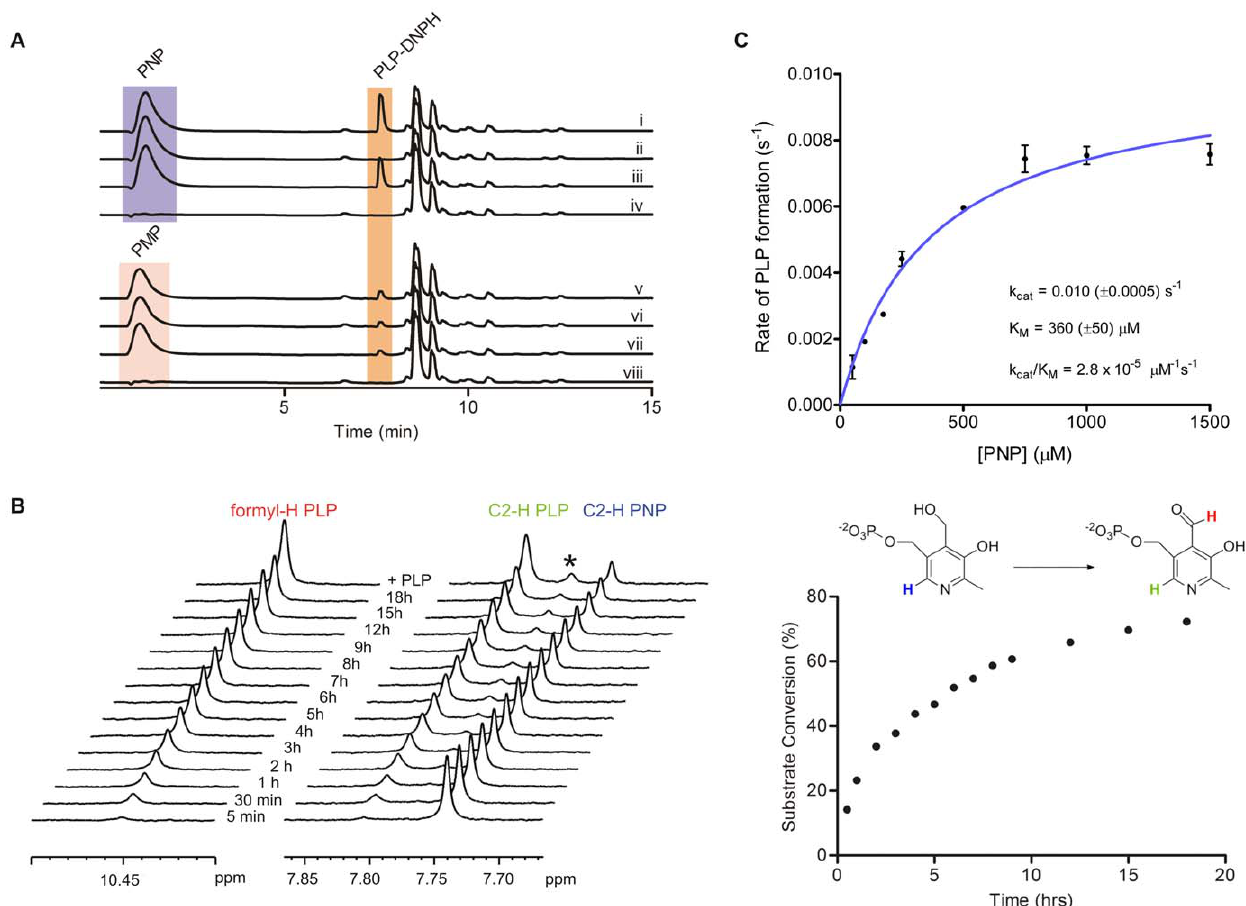
Figure 3. Reverse-phase HPLC, NMR, and spectrophotometric analysis of the PNPOx activity of Rv2607. (A) HPLC chromatograms (270 nm) of reaction mixtures containing PNP (i-iv) or PMP (v-viii), FMN, and Rv2607, and the associated control reactions. All reactions were carried out in 25 mM potassium phosphate buffer (pH 7.8), incubated at 25 u C for 3 h, and quenched with DNPH (0.7 mM final concentration). Where present, the reaction components were at the following concentrations: 1 mM PNP or PMP, 10 m M FMN, and 10 m M Rv2607. Reaction mixtures contained: (i) PNP, FMN, and Rv2607, (ii) PNP and FMN (enzyme negative control), (iii) PNP and Rv2607 (no added FMN), (iv) FMN and Rv2607 (substrate negative control), (v) PMP, FMN, and Rv2607, (vi) PMP and FMN (enzyme negative control), (vii) PMP and Rv2607 (no added FMN), (viii) FMN and Rv2607 (substrate negative control). The peak to the right of PLP-DNPH is DNPH, which has a retention time of 8.6 min. (B) 1 H NMR analysis of the conversion of PNP into PLP with time. The enzymatic reaction (1 mM PNP, 28 m M enzyme, 10% D 2 O in 25 mM potassium phosphate buffer, pH 7.8) was incubated for 18 hours at 298 K in the spectrometer. Left; stacked 1 H NMR spectra recorded at various time points and after the addition of authentic PLP. The starred peak corresponds to PLP hydrate. Right; a plot of percent substrate conversion versus time. Substrate conversion was determined by comparing integrals of the C2- 1 H signals associated with PLP (7.80 ppm) to that of PNP (7.75 ppm). (C) Michaelis-Menten plot for Rv2607 with PNP as a substrate. The rate of PLP formation was monitored spectrophotometrically ( l max = 388 nm, e =4900 cm 2 1 M 2 1 ) for various concentrations of PNP. All solutions were made in 100 mM potassium phosphate buffer (pH 7.8).